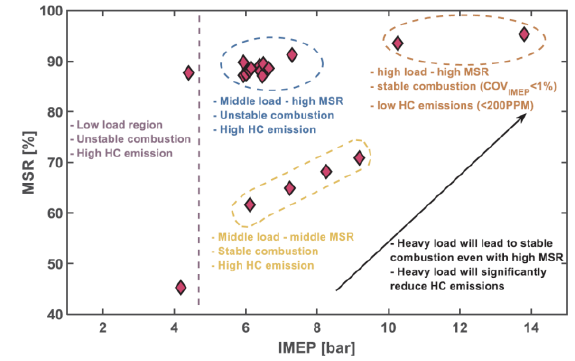
Fig. 16. Summary of studies on direct injection of MeOH and DF (repro- duced from [12]) Similar studies were also conducted by Huang et